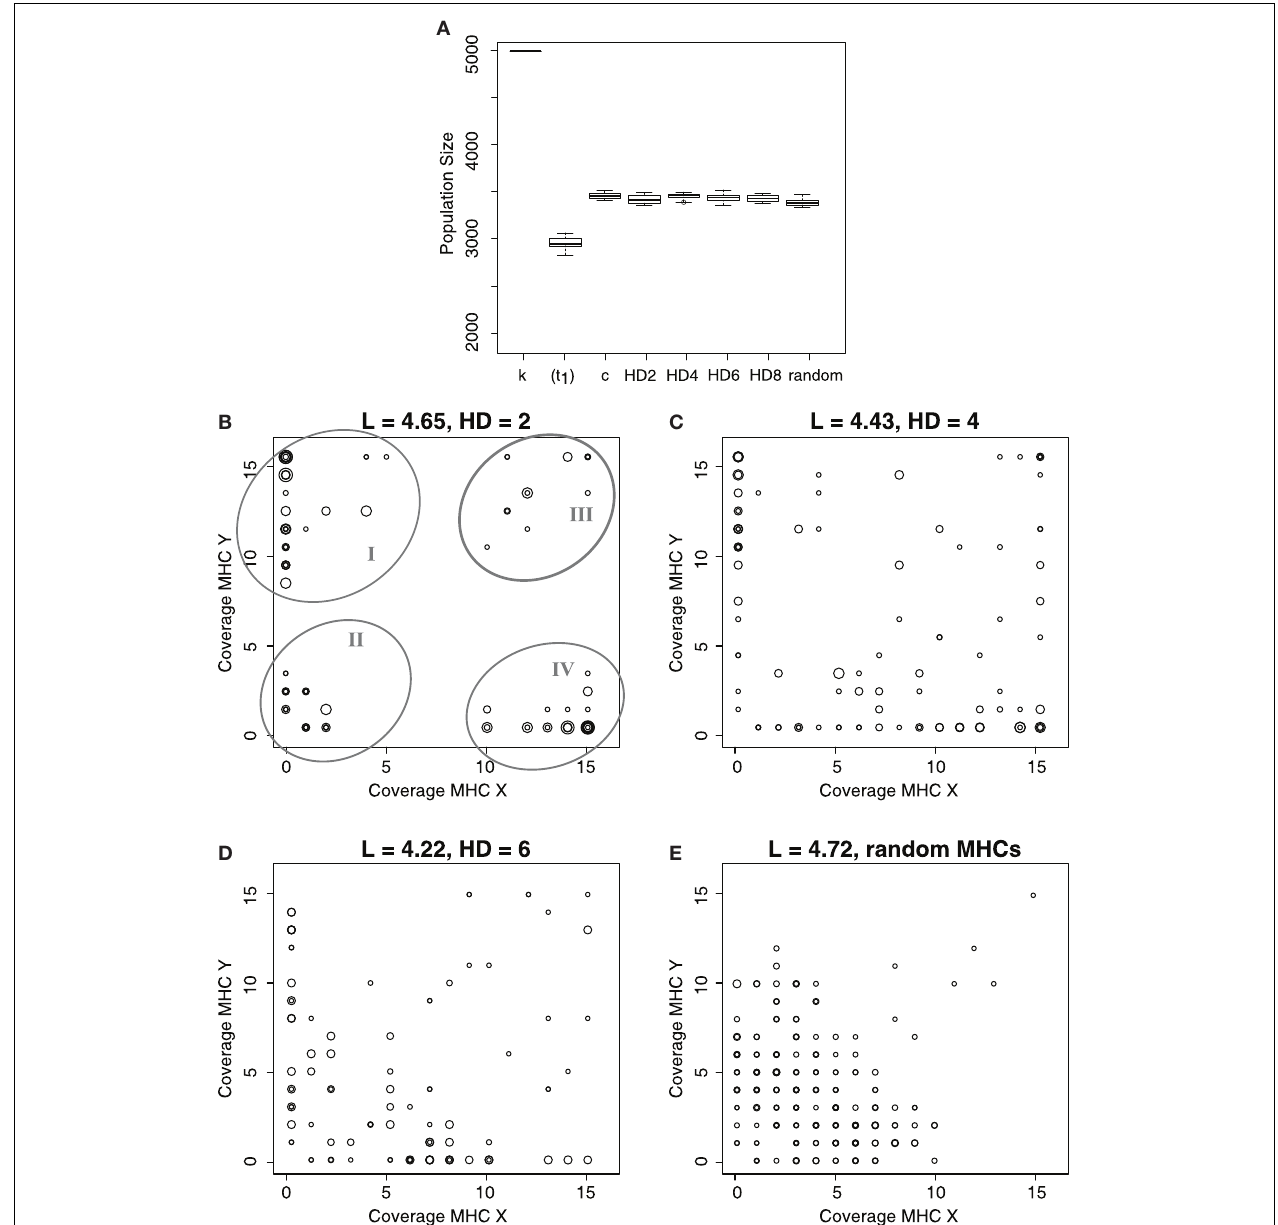
coverage per iNKR and the average binding threshold (L) at t end out of all 10 simulations. Each host population has a different degree of MHC-I similarity, with HD = 2 (C) , HD = 4 (C) , HD = 6 (D) , and completely random MHC molecules (E) . Each iNKR is depicted by one circle, the size of which represents its frequency in the population. The position of each circle shows how many MHC-X and MHC-Y molecules in the population each iNKR can recognize. The boxes in (A) represent the interquartile range, and the bold horizontal lines represent the median taken out of 10 simulations.